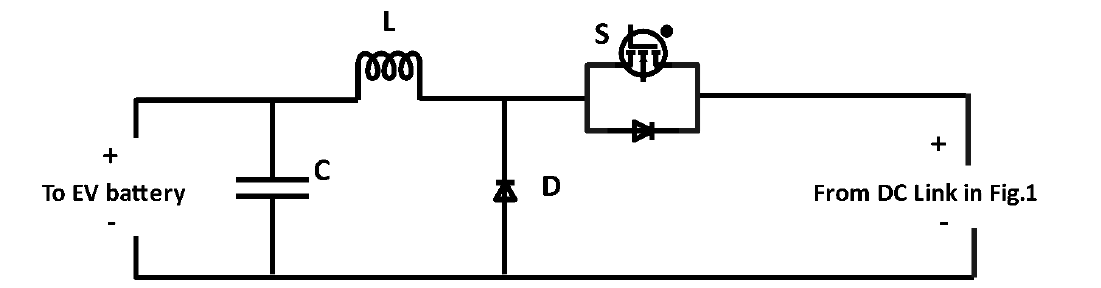
Figure 7. Circuit diagram of buck converter.